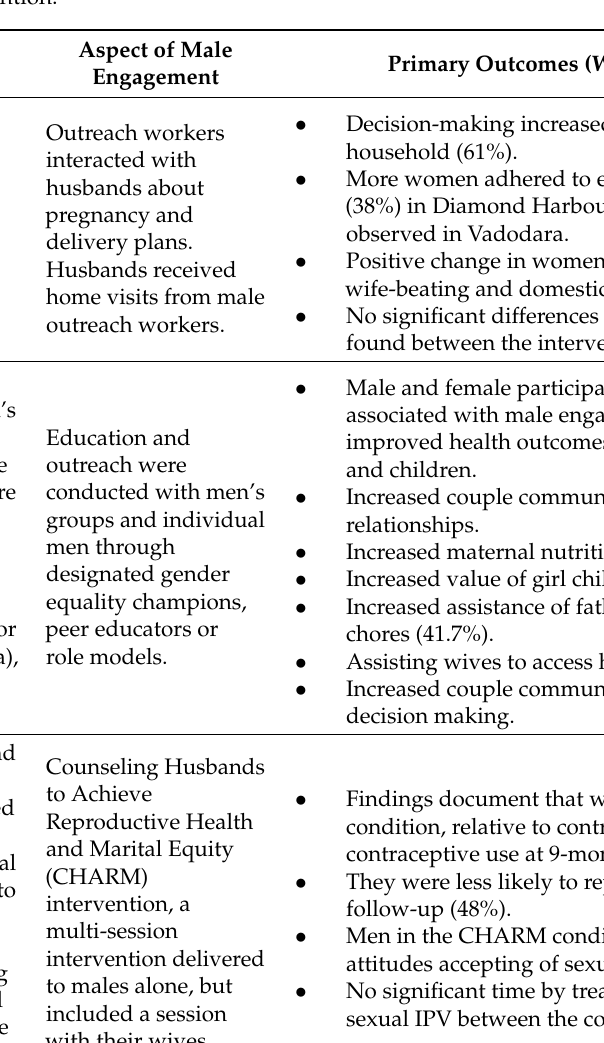
Table 1. Description of study population and components of